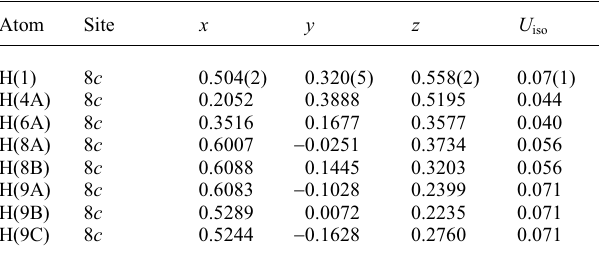
Table 2. Atomic coordinates and displacement parameters (in Å 2 )